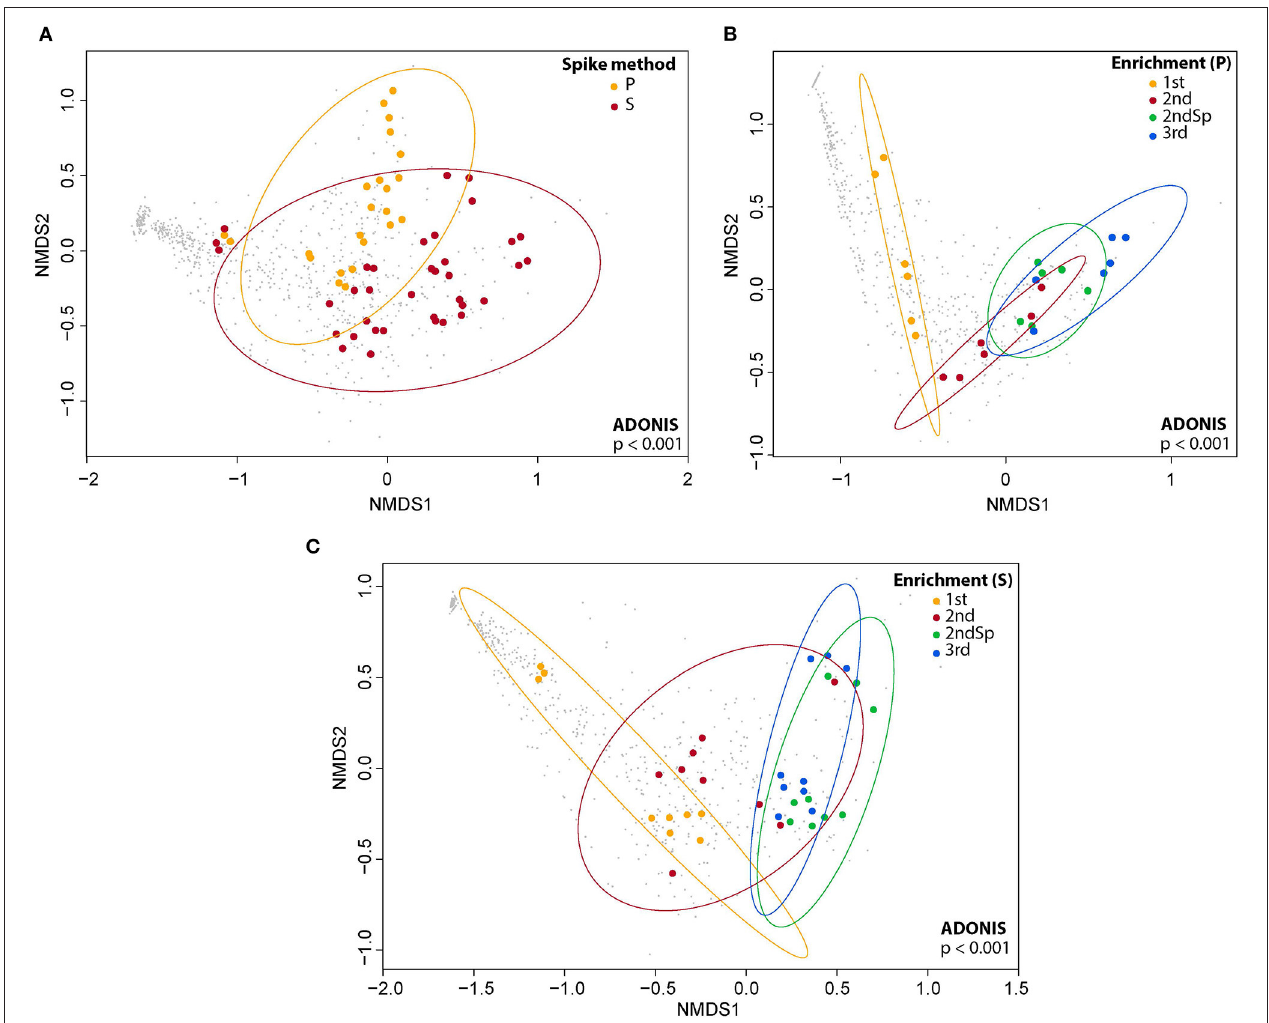
FIGURE 4 | nMDS ordination of the Bray-Curtis dissimilarity between soil bacterial communities of cultures where the herbicides were added in powder form or dissolved in acetone (A) , between soil bacterial communities of different enrichments where both 2,4-D and 2,4,5-T were added in powder form (B) and between soil bacterial communities of different enrichments where 2,4-D and 2,4,5-T were dissolved in acetone (C) . P, herbicides in powder form; S, herbicides dissolved in acetone. Taxonomic variables (OTUs) have been added as gray dots to the background of each ordination using function argument “ points ,” display = “species” of the function “ metaMDS” in